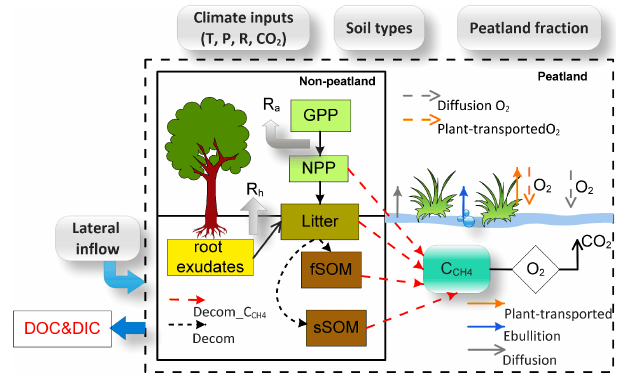
Figure 1. Schematic of carbon components and cycling in LPJG- WHyMe-TFM. The solid-line box includes carbon cycling for non- peatland cell, whereas the items inside the dashed-line box represent processes particular to the peatland cells. Only DOC&DIC in red text is not explicitly presented in the current model. T : air tempera- ture; P : precipitation; R : radiation; CO 2 : atmospheric CO 2 concen- tration; Decom_C CH : decomposed materials allocated to C CH 4 Decom: